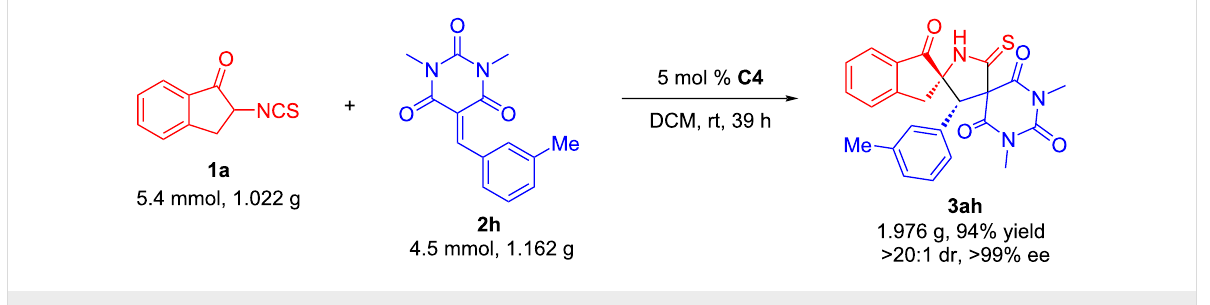
Scheme 4: Gram-scale synthesis of 3ah